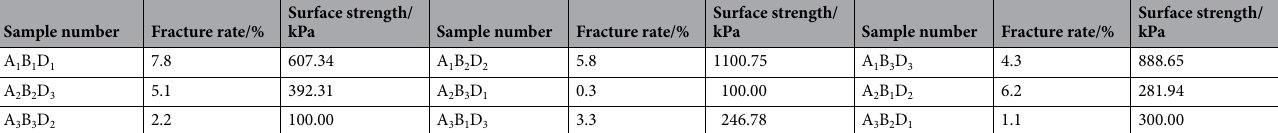
Table 7. Results of freeze–thaw orthogonal